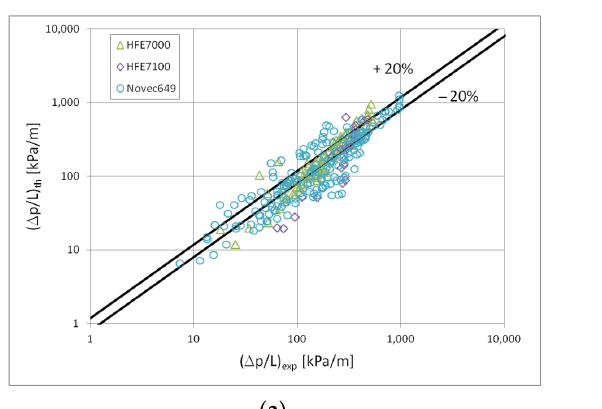
( b ) Figure 13. Comparison of the results of experimental studies on the condensation of the investi- gated refrigerants in mini-channels in terms of pressure drops with the proprietary correlation (3) for the dispersion structure; ( a ) for individual refrigerant, ( b ) for individual mini-channels diame- ters.